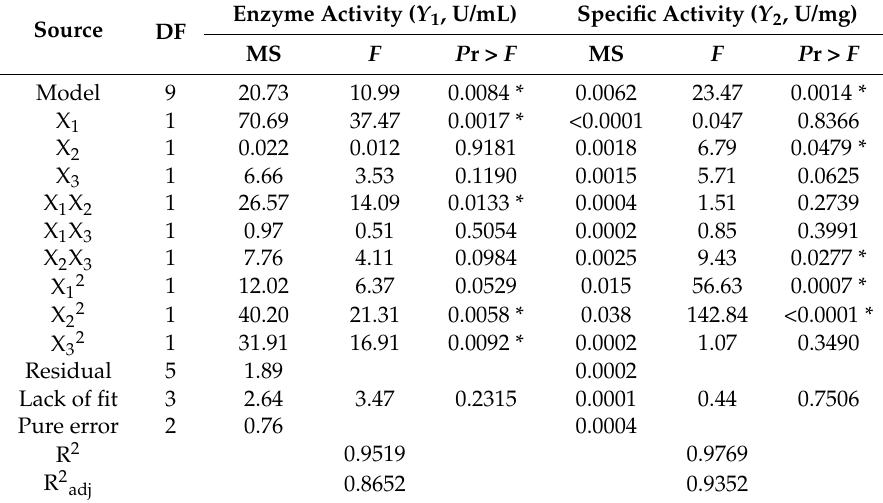
Table 2. ANOVA for enzyme activity ( Y 1 , U/mL) and specific activity ( Y 2 ,